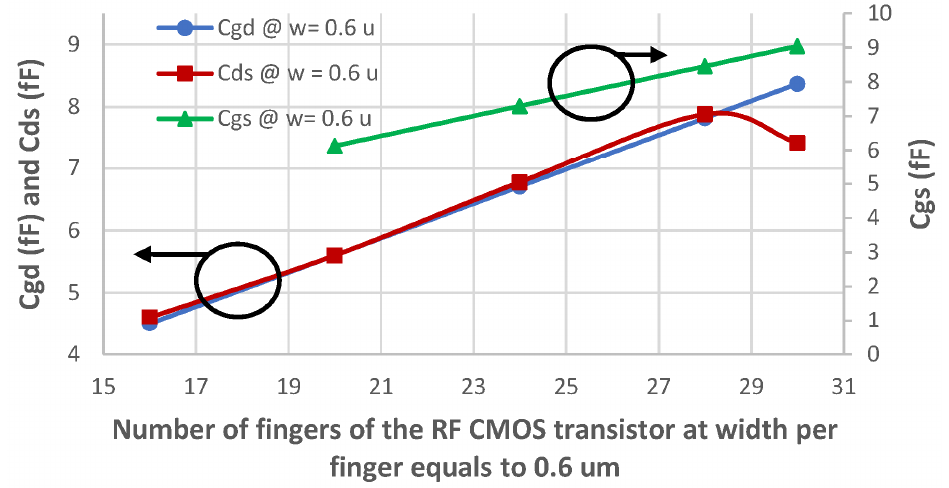
Figure 4. Estimated extra parasitic gate-to-drain capacitance, extra parasitic drain-to-source capaci- tance, and extra parasitic gate-to-source capacitance versus MOSFET’s number of fingers (N) at width per finger equals 0.6 um.